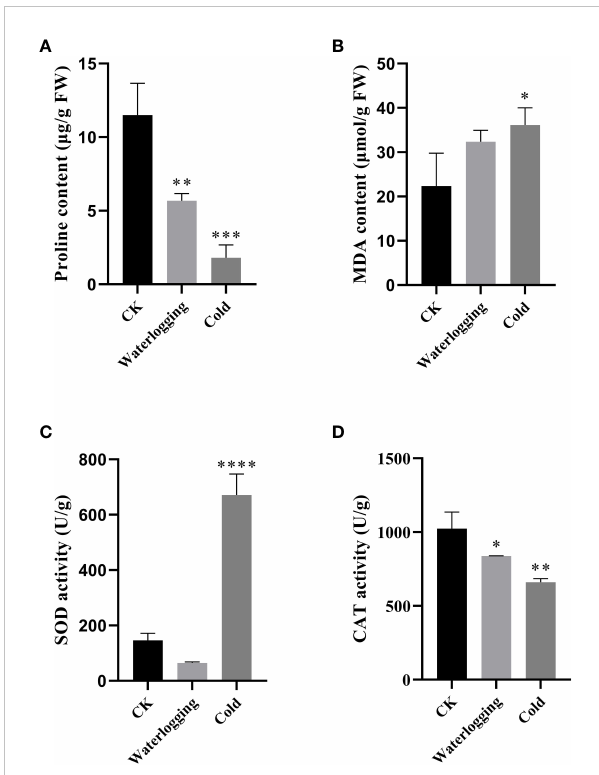
FIGURE 10 Physiological changes under waterlogging stress and cold stress after 10 days in pumpkin. (A) ; proline content. (B) ; MDA content. (C) ; SOD activity. (D) ; CAT activity. The values are denoted as the means ± SDs. The signi fi cant difference is represented by asterisks at * P < 0.05, ** P < 0.01, *** P < 0.001 and **** P <